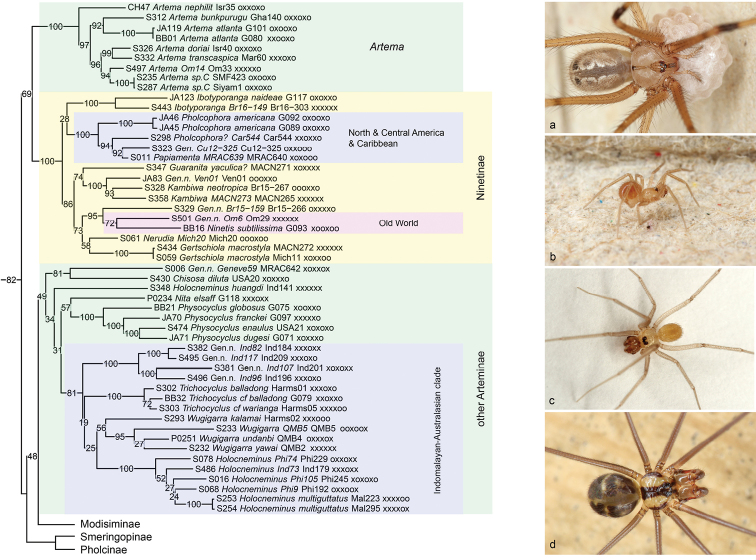
Ninetinae and ArteminaeaArtema sp. n. “Om14” (Oman) b Gen. n. (Ninetinae) sp. n. “Om6” (Oman) cChisosadiluta (USA) d Gen. n. (Arteminae) sp. n. “Ind82” (Sulawesi).